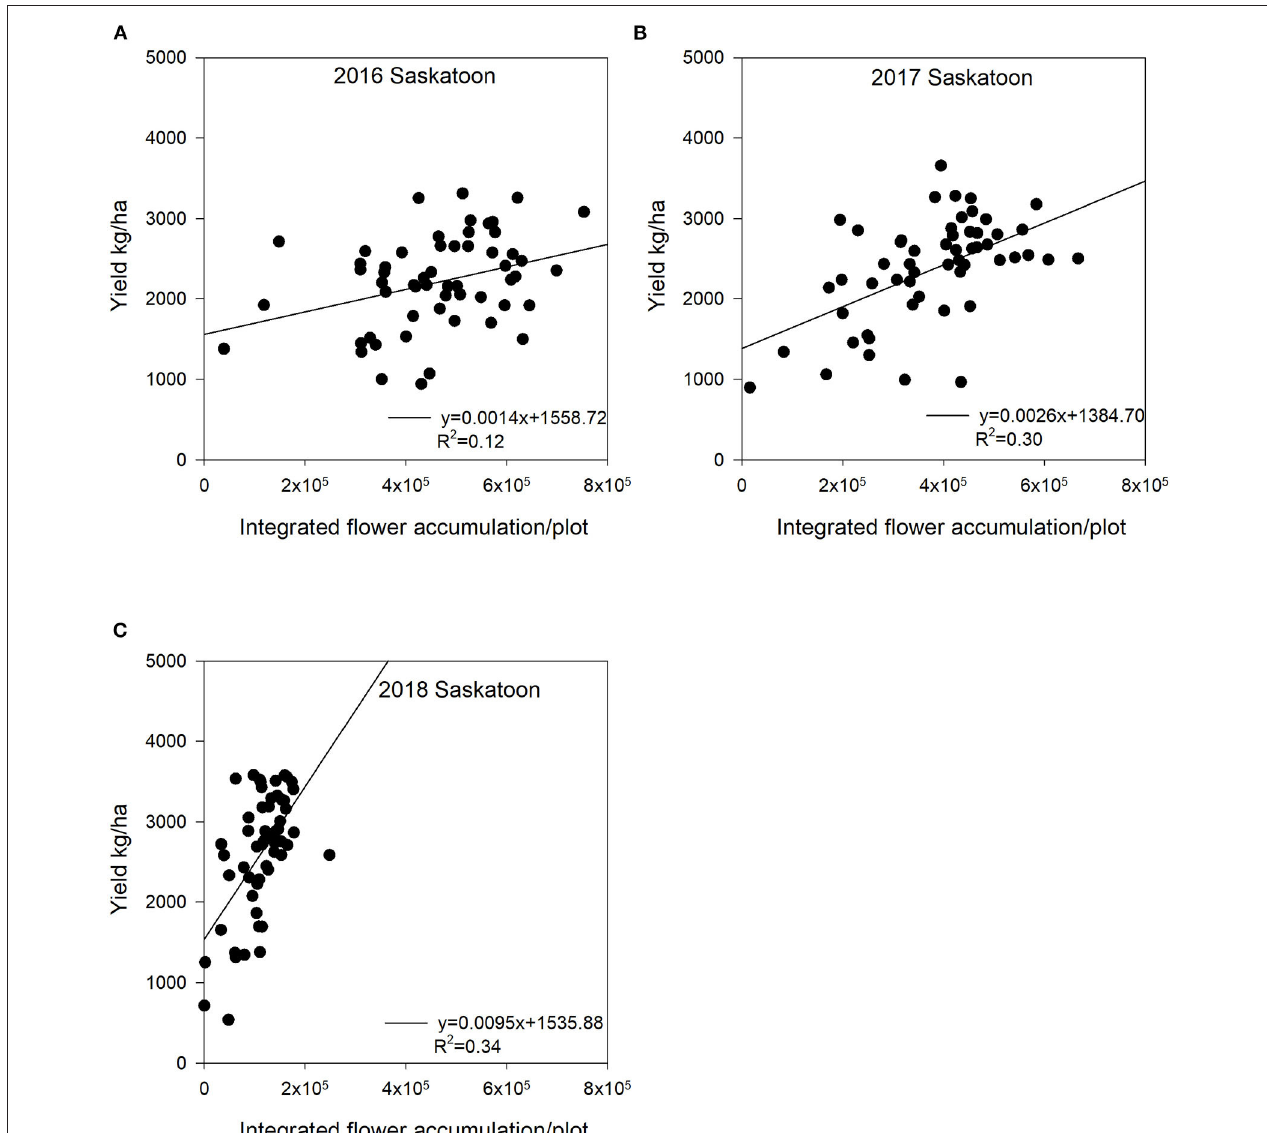
FIGURE 8 | The relationship between seed yield and integrated flower accumulation at Saskatoon, SK, Canada from 2016 to 2018. The integrated flower accumulation was calculated using the area under the flowering progress curve function. (A) Regression for the Saskatoon location in 2016: y = 0.0014x + 1558.72, R 2 = 0.12. (B) Regression for the Saskatoon location in 2017: y = 0.0026x + 1384.70, R 2 = 0.30. (C) Regression for the Saskatoon location in 2018: y = 0.0095x + 1535.88, R 2 =